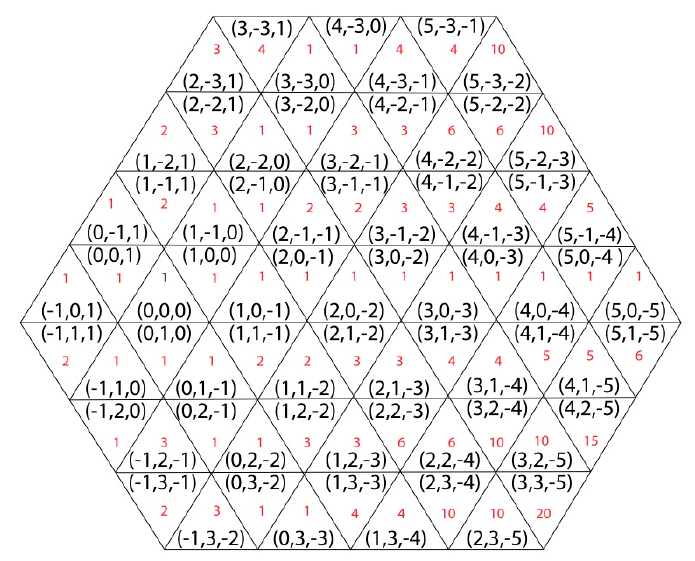
Figure 3. The number of shortest weighed paths from trixel (0,0,0) to other trixels of the grid with the condition 2 α < β and 3 α < γ .